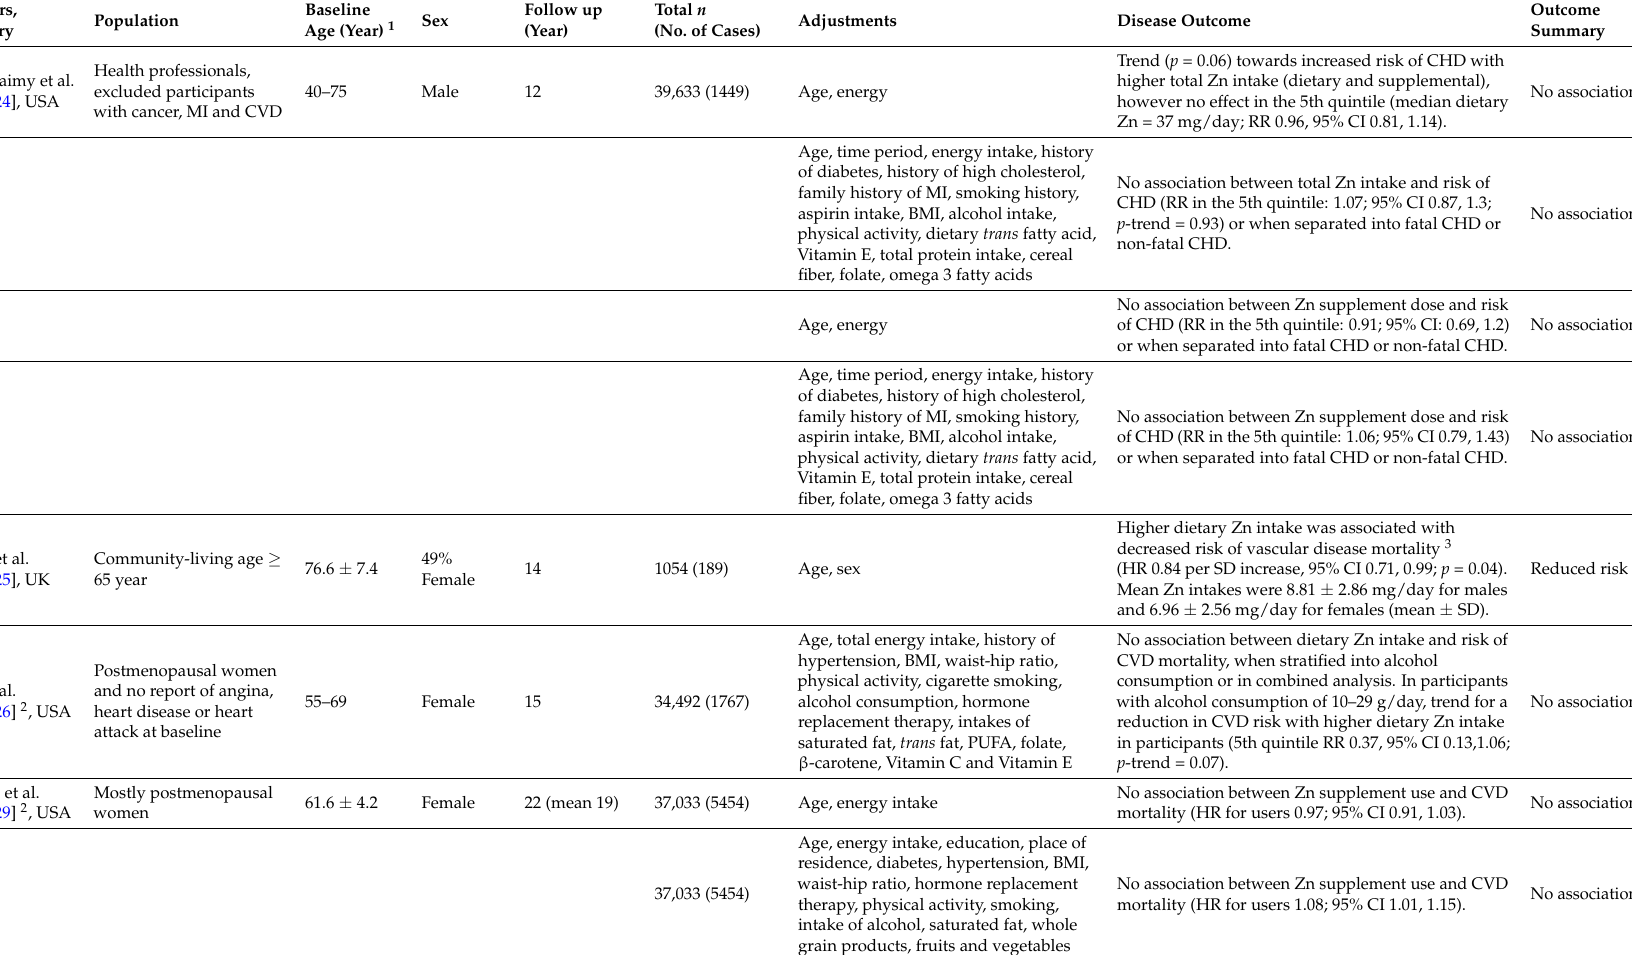
Table 1. Relationship between dietary and/or supplemental zinc intake and cardiovascular disease events in prospective cohort